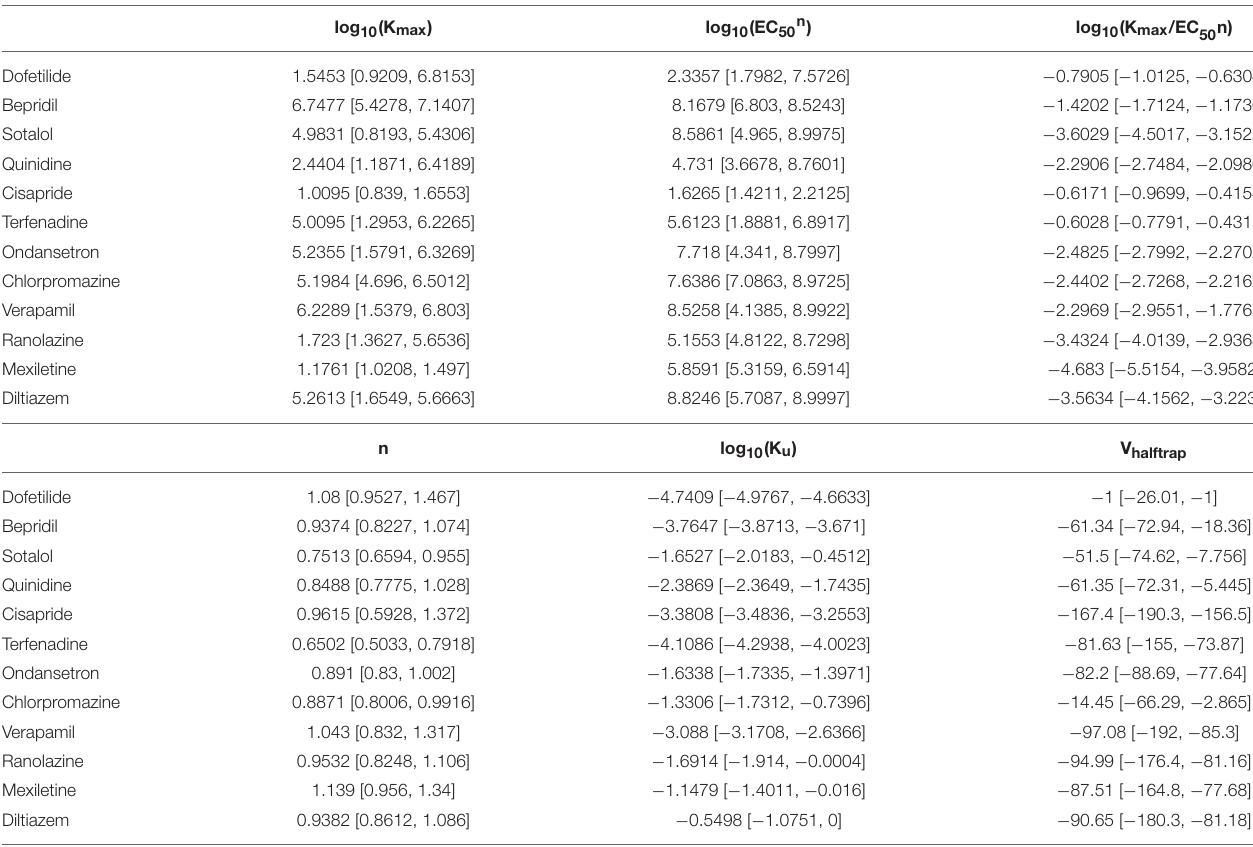
TABLE 2 | Drug-hERG binding parameters for the 12 CiPA training